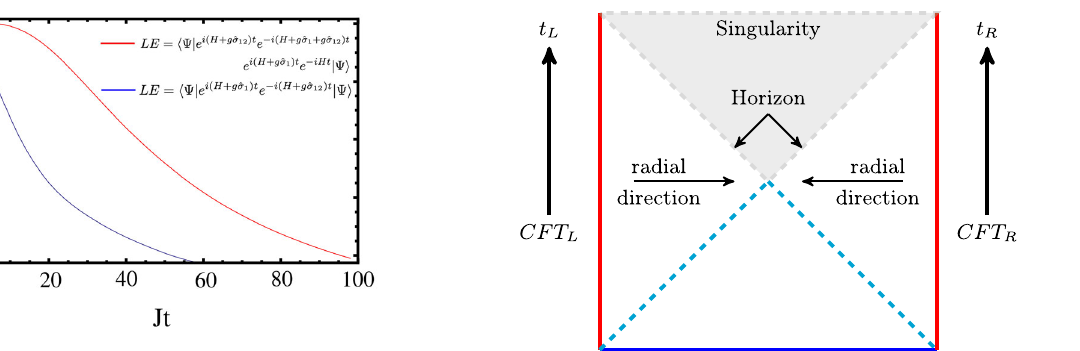
Fig. 7 Penrose diagram of an eternal AdS-Schwarzschild black hole